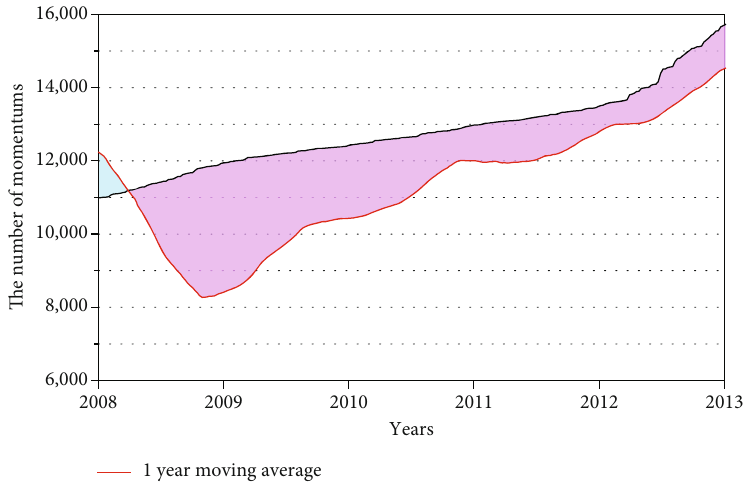
Figure 8: Time series plot of changes